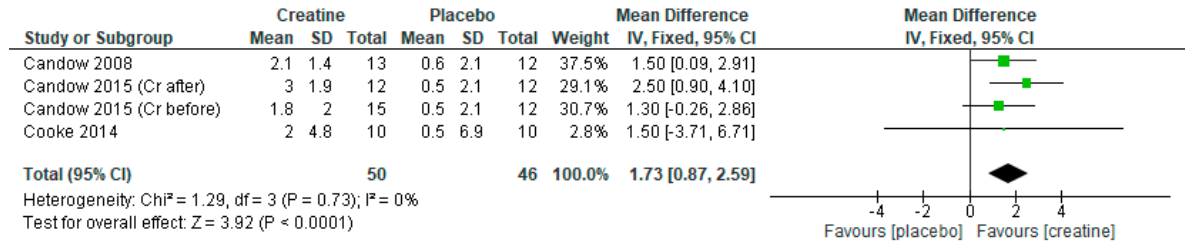
Figure 6. Forest plot of studies on lean tissue mass.